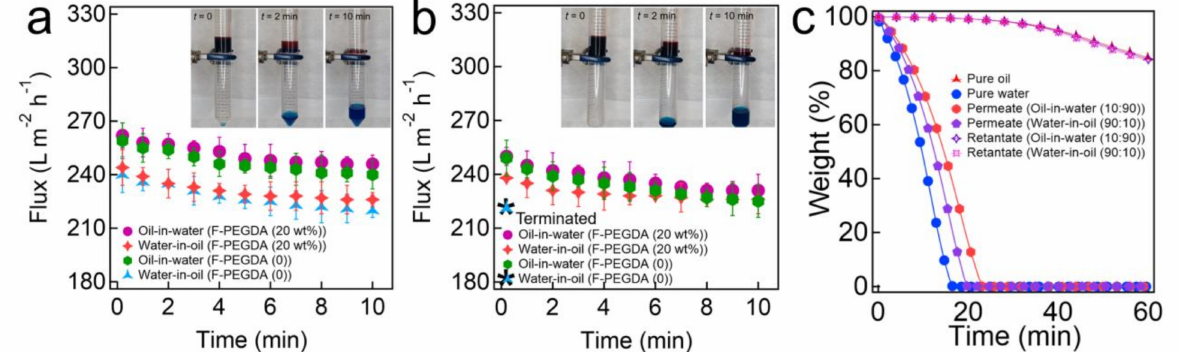
Figure 3. ( a – c ) Time-dependent flux measurements during the separation of oil-water mixtures under gravity by ( a ) prewet- ted and ( b ) dry filters coated with F-PEGDA (20 wt.%) and neat PEGDA. The inset shows images of the oil-water separation experiments with oil-in-water emulsions by utilizing a filter coated with F-PEGDA (20 wt.%). ( c ) The TGA plots of the permeate and retentates after the separation of both oil-in-water and water-in-oil emulsions using a filter coated with F-PEGDA (20 wt.%). The TGA data for pure water and oil are also shown for